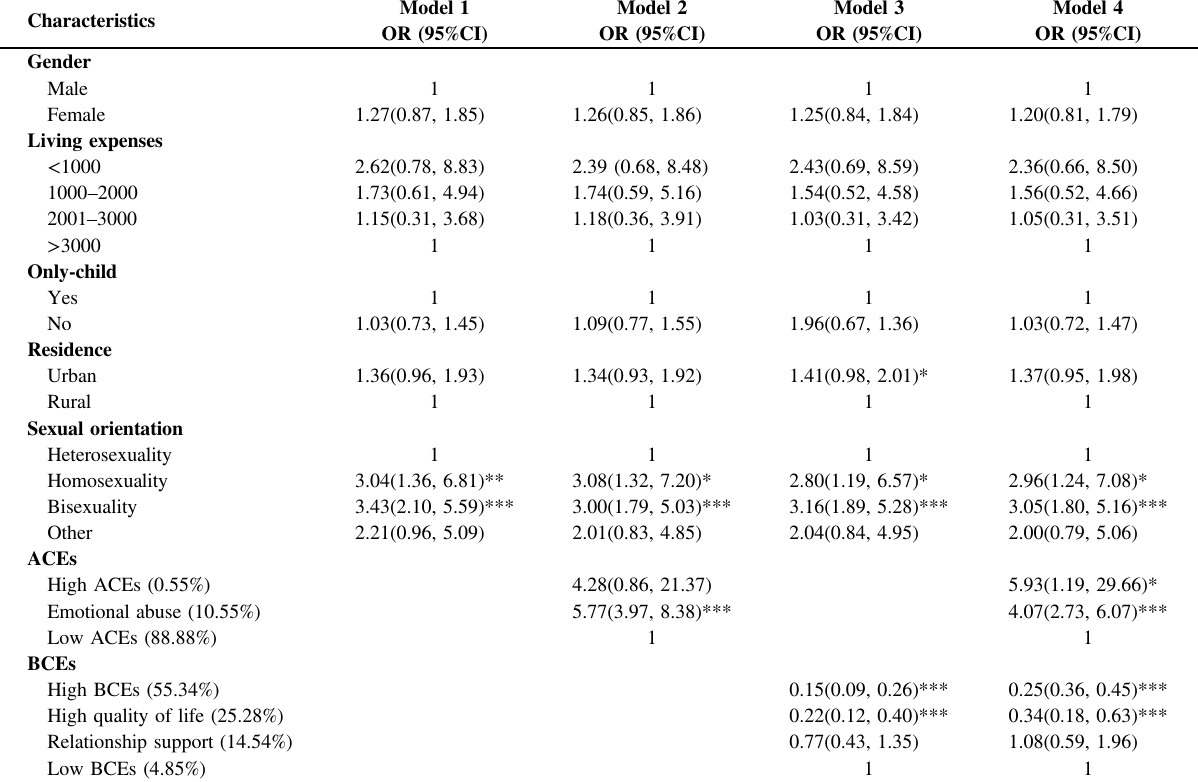
Table 4 Associations between childhood experiences and suicidal ideation among Chinese undergraduates